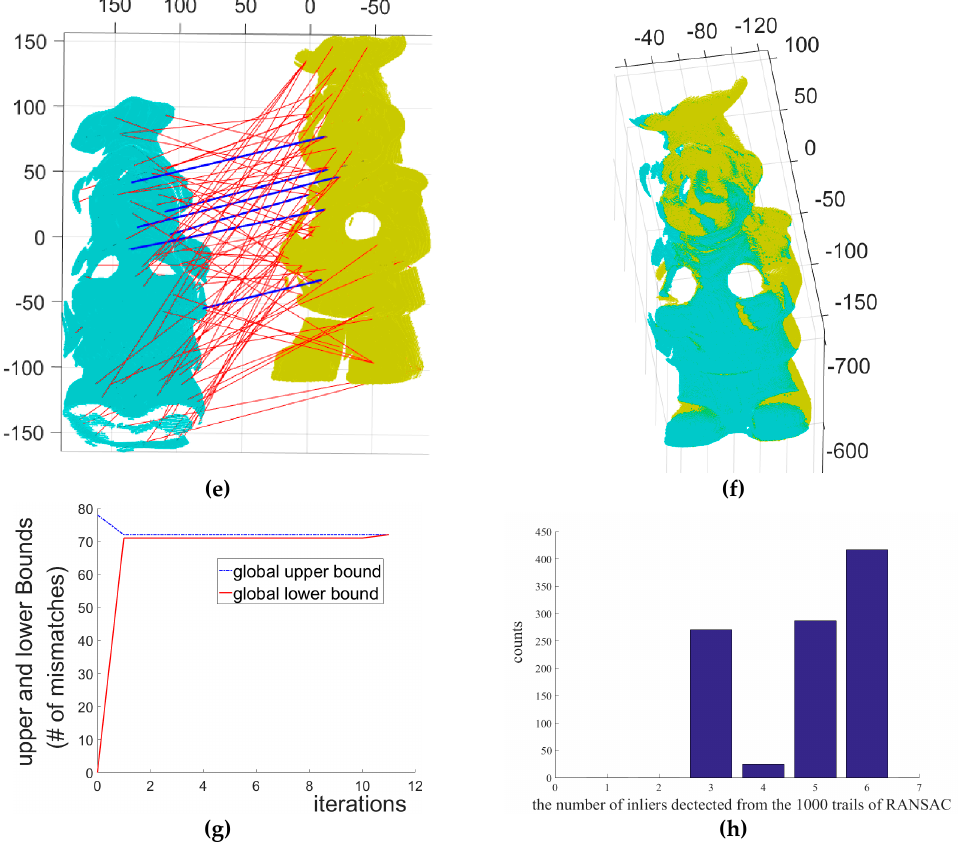
Figure 5. 3D registration results for the proposed method and others: ( a , b ) two input range images, ( c ) initial pose of two input data ( a , b , d ) range images aligned by ICP, ( e ) the correct and incorrect matches detected by the proposed method, where blue and red lines denote a correct one and a mismatch, respectively, ( f ) range images aligned by our branch-and-bound, ( g ) convergence of the global lower and upper bounds of our branch-and-bound, and ( h ) histogram of the number of inliers classified by RANSAC.